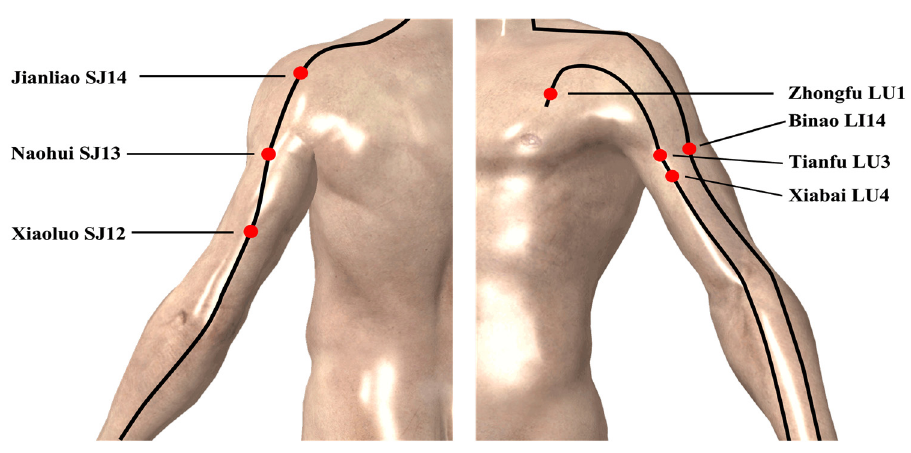
Figure 4. Acupuncture points.